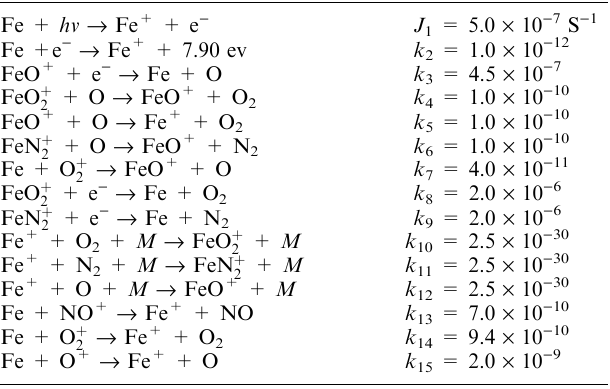
Table 1. Chemical reactions and rate constants (cm 3 s ) 1 ; cm 6 s ) 1 for three-body reactions) used in the 2-D version of the model, based on the compilation by Brown (1973). Temperature depen- dences for all rate constants listed here, except for the last three, are unknown or highly uncertain and hence are kept constant in the simulations corresponding to a nominal value of T = 200 K. Rate constants for the last three reactions are assumed to vary between T = 150 K and T = 1350 K, based on the measurements of Rutherford and Vroom (1972), also included in Brown (1973); the rates listed here for these reactions are applicable to the range 750 K–1050 K Fe + hv fi Fe + + e ) J = 5.0 · 10 ) 7 S ) 1